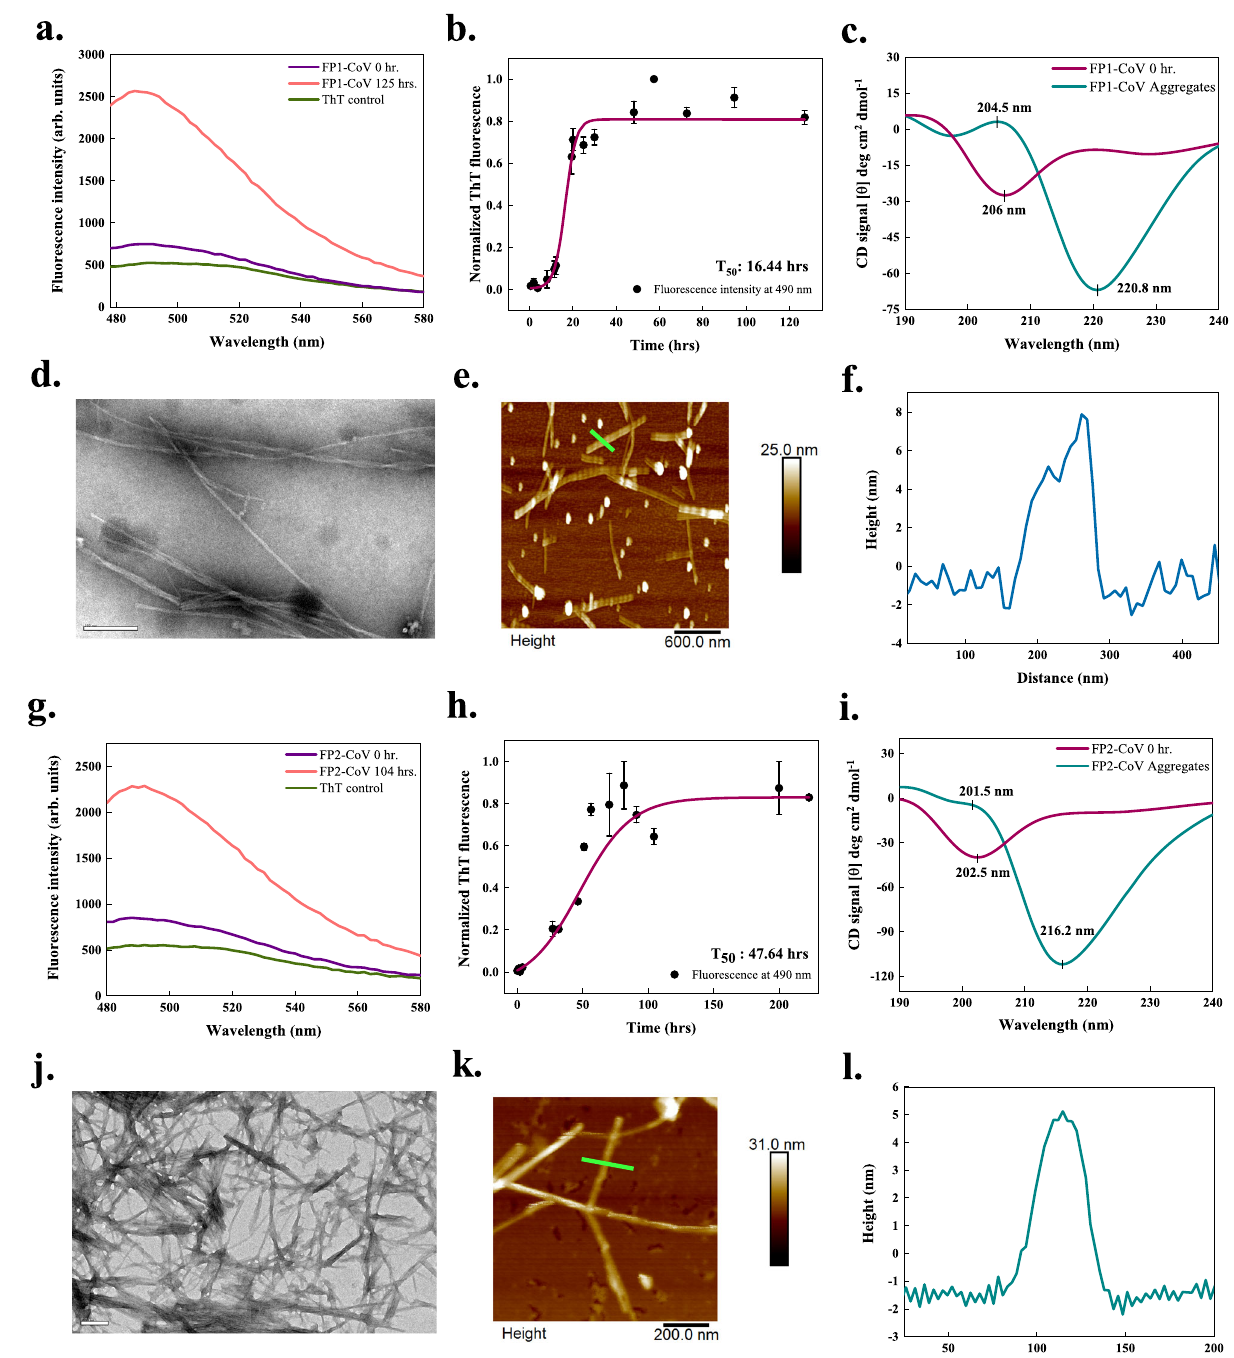
Fig. 3 | In vitro aggregation of fusion peptides 1 (FP1-CoV) and 2 (FP2-CoV) of SARS-CoV S protein. a , g ThT fl uorescence scan ( λ ex 440nm) shows ~3.5- and ~3- fold increment at λ max with FP1-CoV and FP2-CoV incubated samples, respectively. b , h Aggregation kinetics monitored using ThT fl uorescence. Each dotted symbol represents the average value of two (FP2-CoV) and three (FP1-CoV) technical replicates and error bar represents the SEM of these replicates. The wine-coloured lines show the sigmoidal fi ttings of data points that determines the T 50 values as 16.44±0.84h and 47.64±3.75h for FP1-CoV and FP2-CoV peptides, respectively. c , i The secondary structure of 1mg/ml monomeric and aggregated (240h) pep- tides are investigated using CD spectroscopy. The spectra of the monomeric FP1- CoVshowanegativepeakat206nm,exposingamoltenglobule-likestructure.For aggregates, two characteristic peaks, one positive at 204.5nm and a negative peak at~220nm,showthepresenceof β -sheetrichsecondarystructure.Spectraldataof